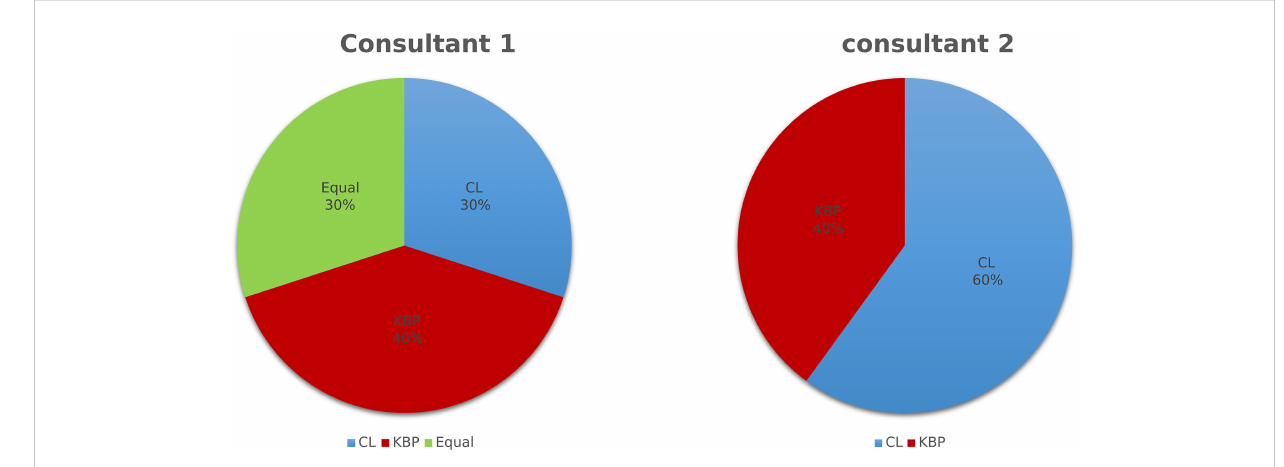
FIGURE 6 Blinded review result for 40 Gy in 5